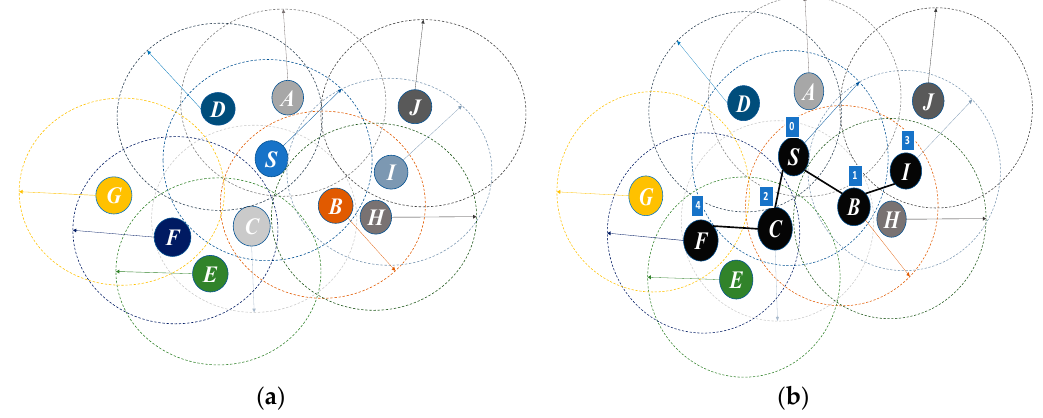
Figure 1. Wireless sensor network example. ( a ) A sensor network before applying EERS. ( b ) The EERS chooses the reference nodes (colored in black) and assigns schedule time slot to each reference.